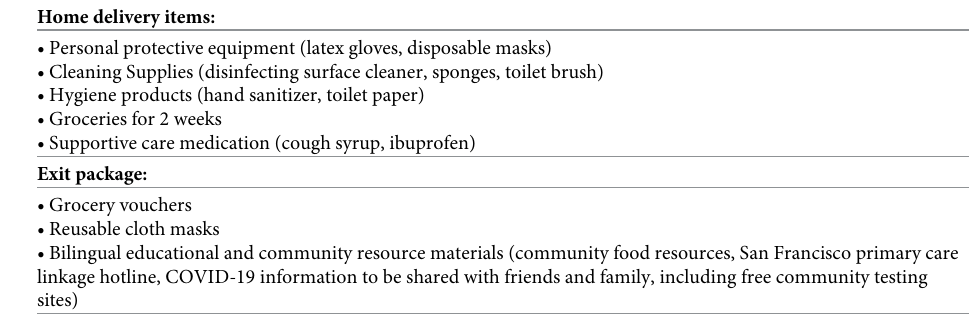
Table 2. Overview of goods and products provided through home delivery by